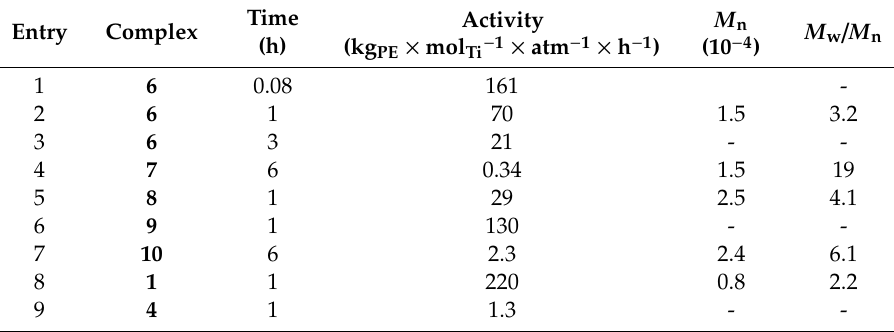
Table 3. Ethylene polymerization catalyzed by 1 , 4 , 6 -10 / MAO systems [8].